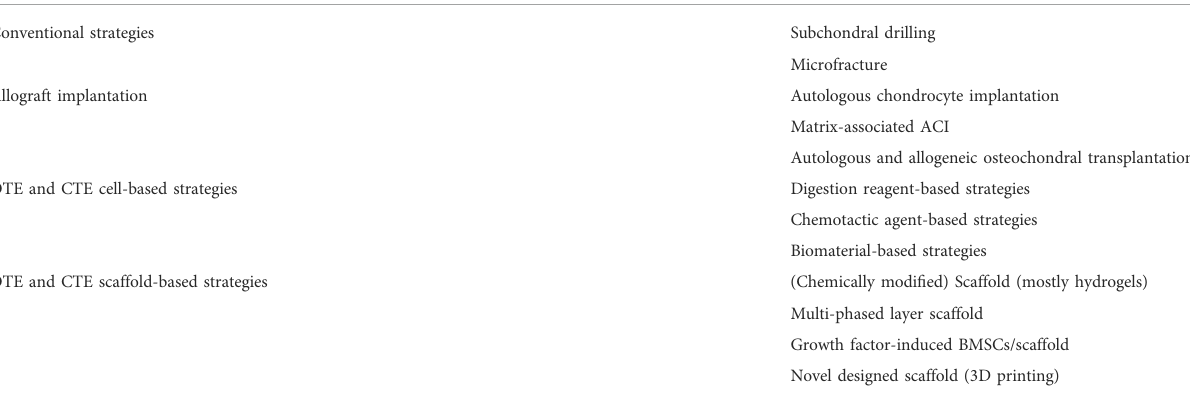
TABLE 3 CCL regeneration